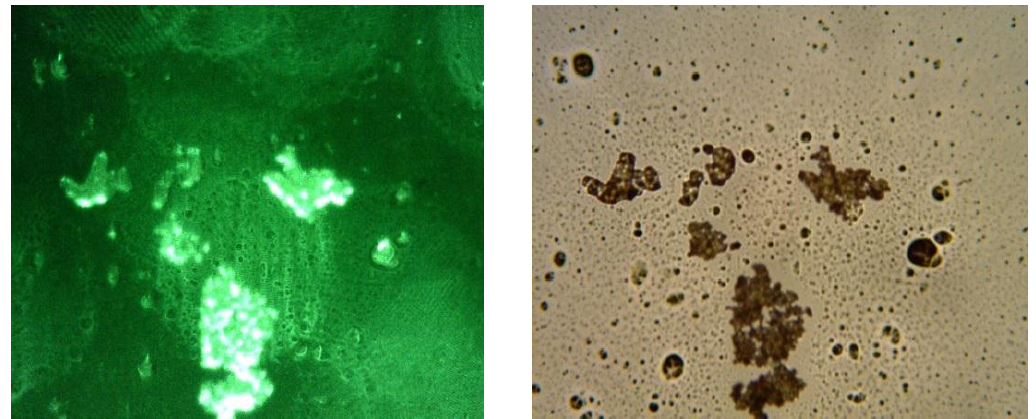
Fig.8: The typical fluorescence microscope images for synthesized